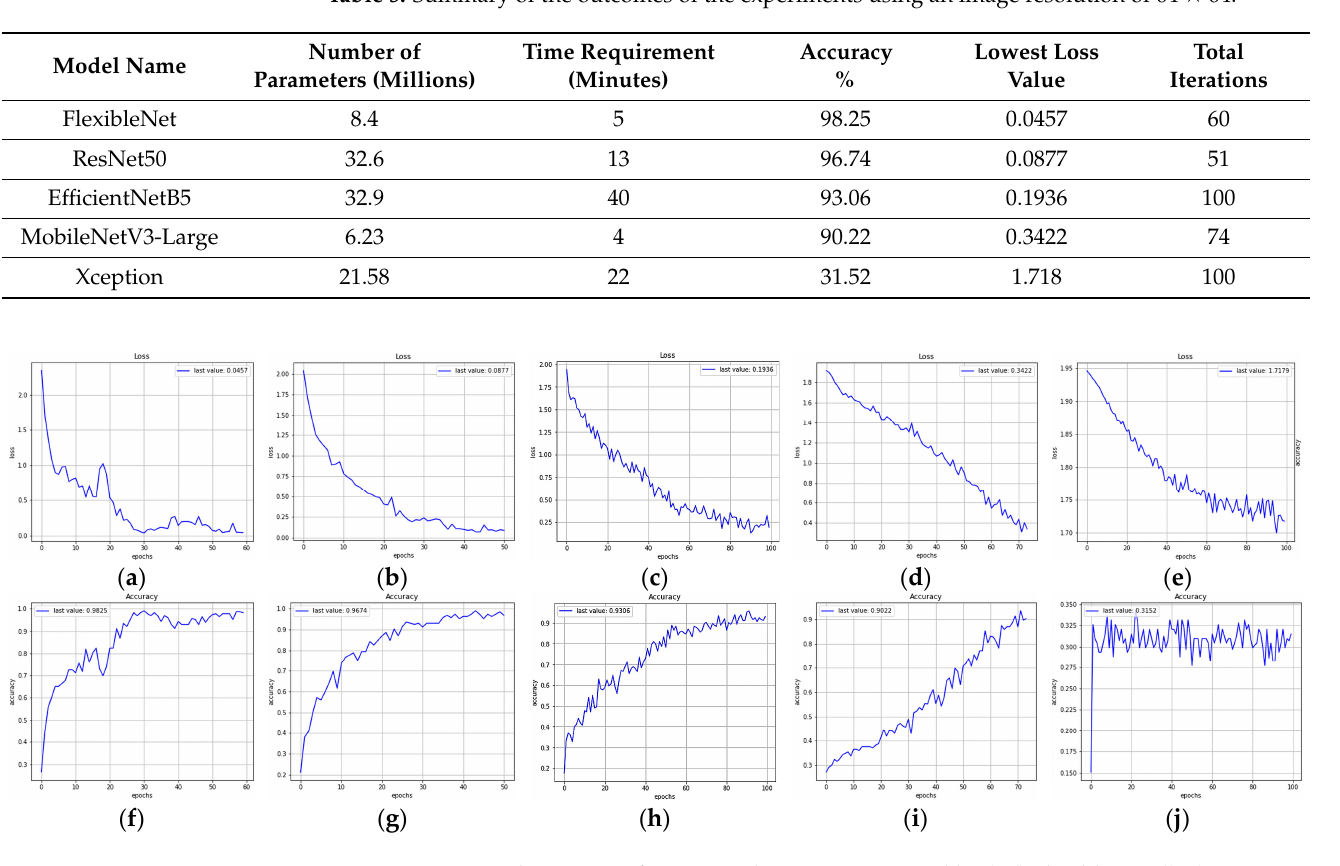
( h ) Figure 13. Sentinel-2 sub-images (128 × 128): ( a – d ) original and ( e – h ) canopy density. We placed constraints on running the FlexibleNet model and the other tested models to avoid falling into the overfitting problem because of a lack of a large dataset of images